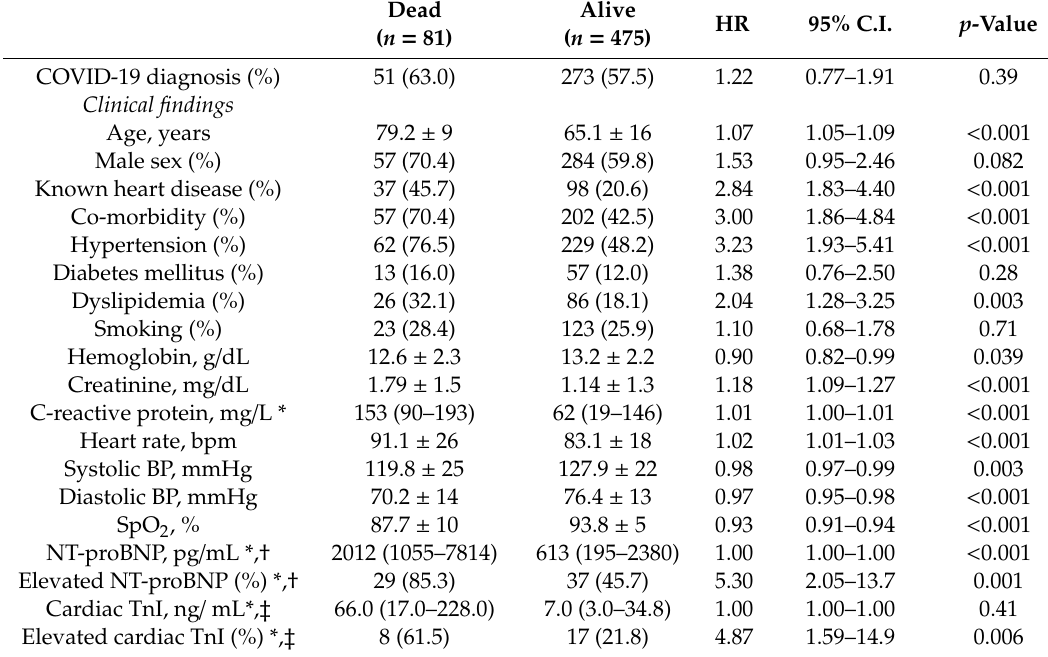
Table 3. Main clinical and ECG findings of dead and alive patients in the whole population of acute infectious respiratory disease (AIRD)